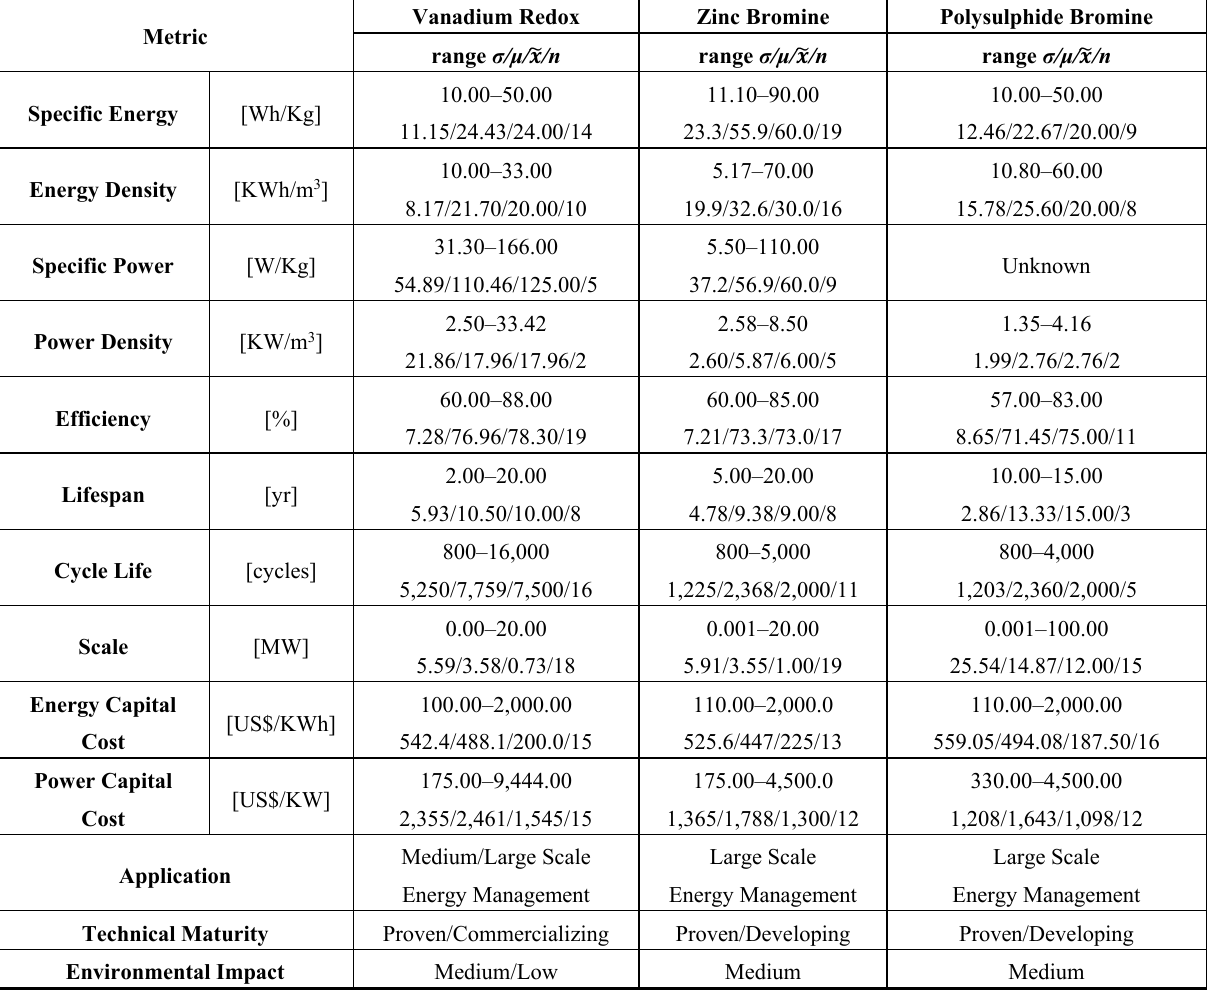
Table 8. Comparing (chemical) flow batteries based on thirteen different metrics. Data obtained or calculated from multiple sources